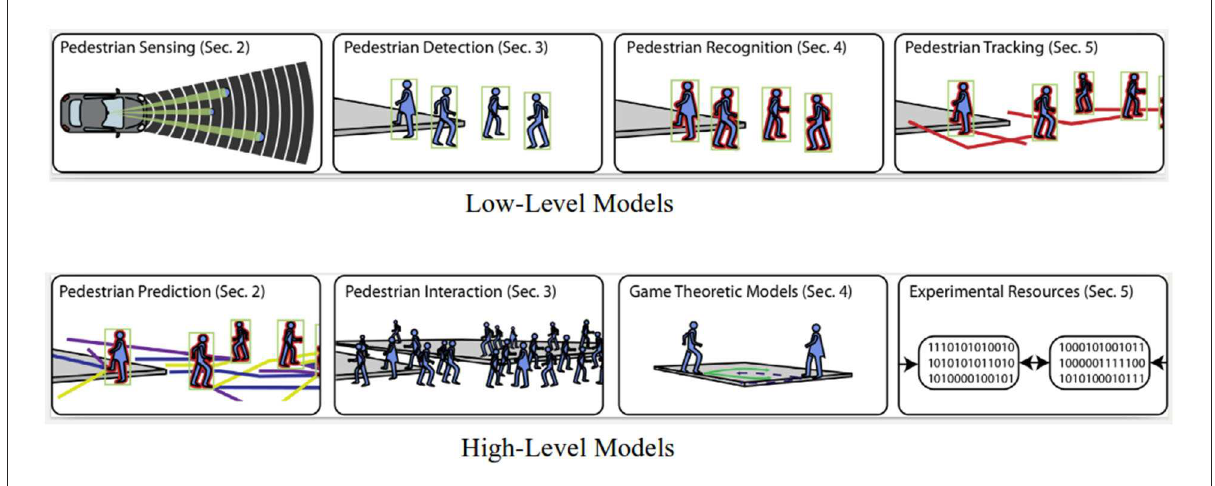
FIGURE2 Proposed taxonomy of low-level (Camara et al., 2020a) and high-level models (Camara et al., 2020b) of pedestrian behavior.